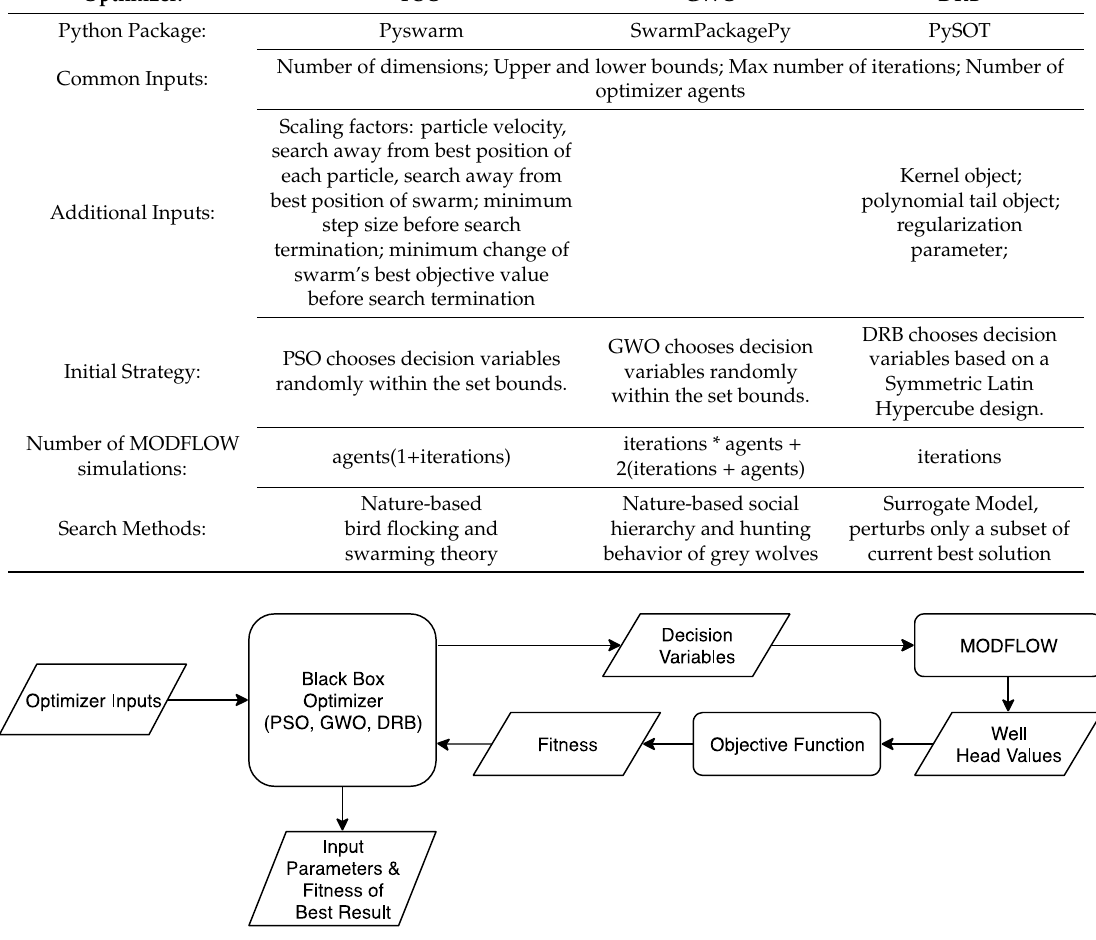
Figure 1. Flowchart of calibration process for the global optimizers. PSO: Particle Swarm Optimization; GWO: Gray Wolf Optimization; DRB: DYCORS/radial basis function.